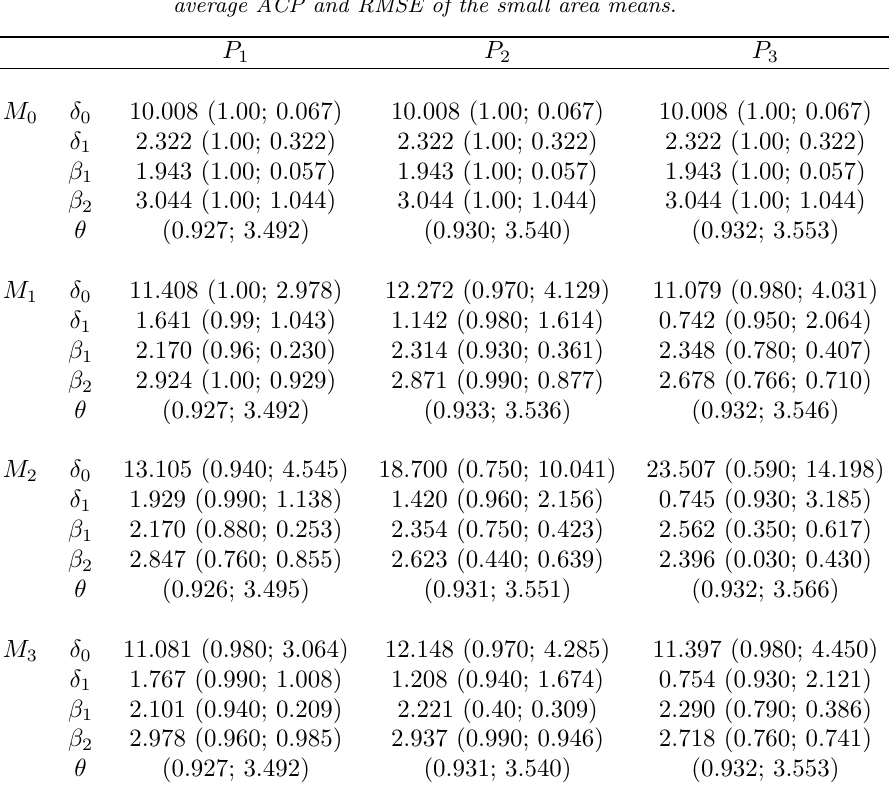
Non Invariant PRAM: posterior mean by misclassification probability P for different models. In parentheses ACP and RMSE, respectively. In the last line, we show the average ACP and RMSE of the small area